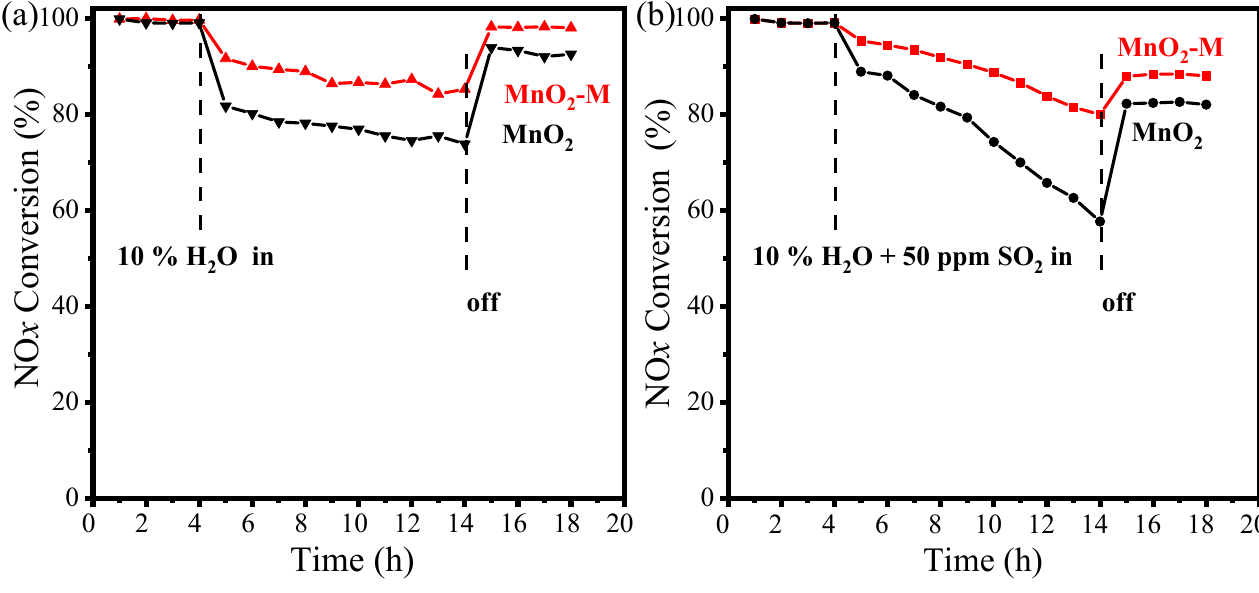
Figure 9. The effect of H 2 O on NO x conversion over the catalysts ( a ) and the effect of SO 2 and H 2 O on NO x conversion at 150 °C ( b ) (reaction conditions: [NO] = 500 ppm, [NH 3 ] = 500 ppm, [O 2 ] = 5%, and N 2 as balance gas, [H 2 O(g)] = 10 vol.% (in use), [SO 2 ] = 50 ppm (in use), GHSV = 40,000 h −1 ).